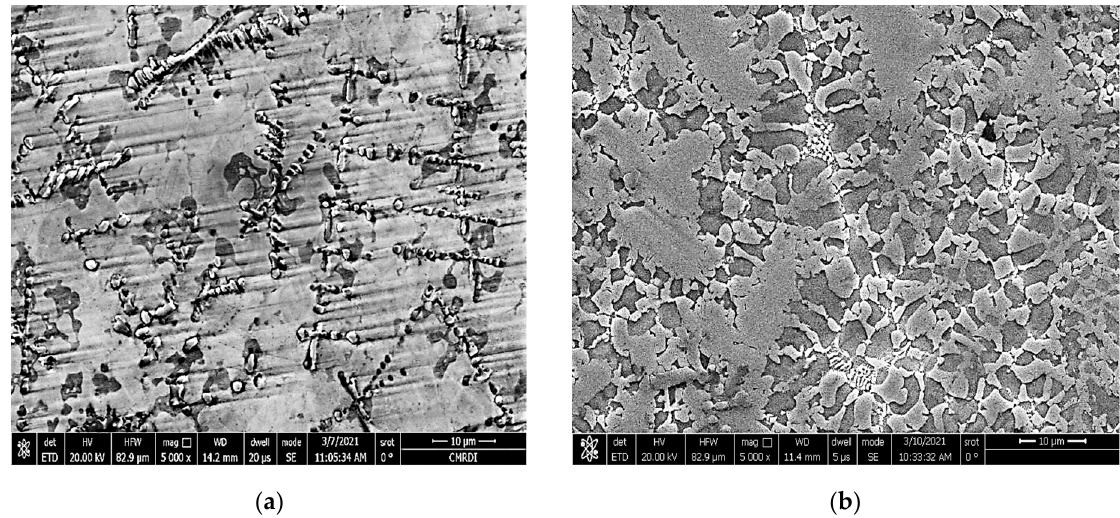
Figure 5. FESEM micrographs of the ( a ) hypoeutectic structure in the DZ and ( b ) dendritic structure of the IZ.